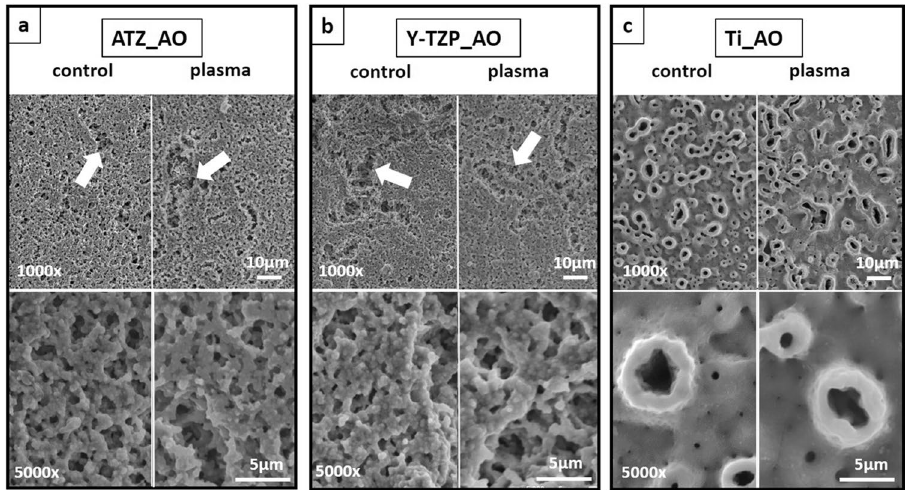
Figure 1. SEM images of ATZ ( a ), Y-TZP ( b ) and titanium ( c ) surfaces for osteoblast culture. Magnifications were set to 1000x (first row) and 5000x (second row). Arrows point to macroscopic grooves and gaps on ceramic